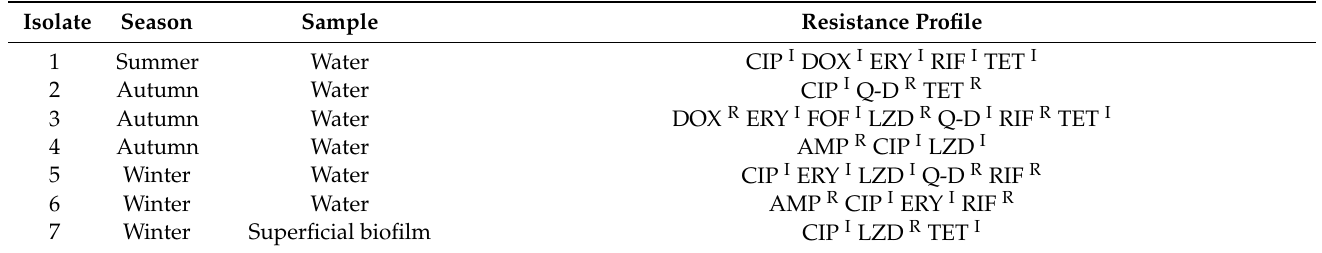
Table 5. Resistance patterns in Enterococcus spp. MDR strains isolated from the farming water, edible portion, and superficial biofilm samples.